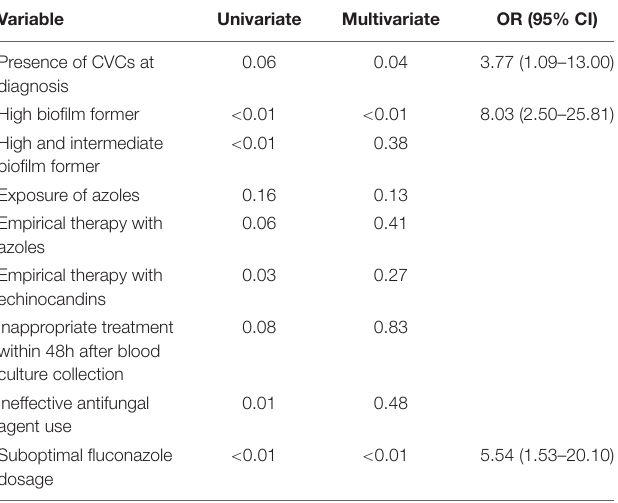
TABLE 4 | Multivariate logistic regression analysis for independent factors of persistent